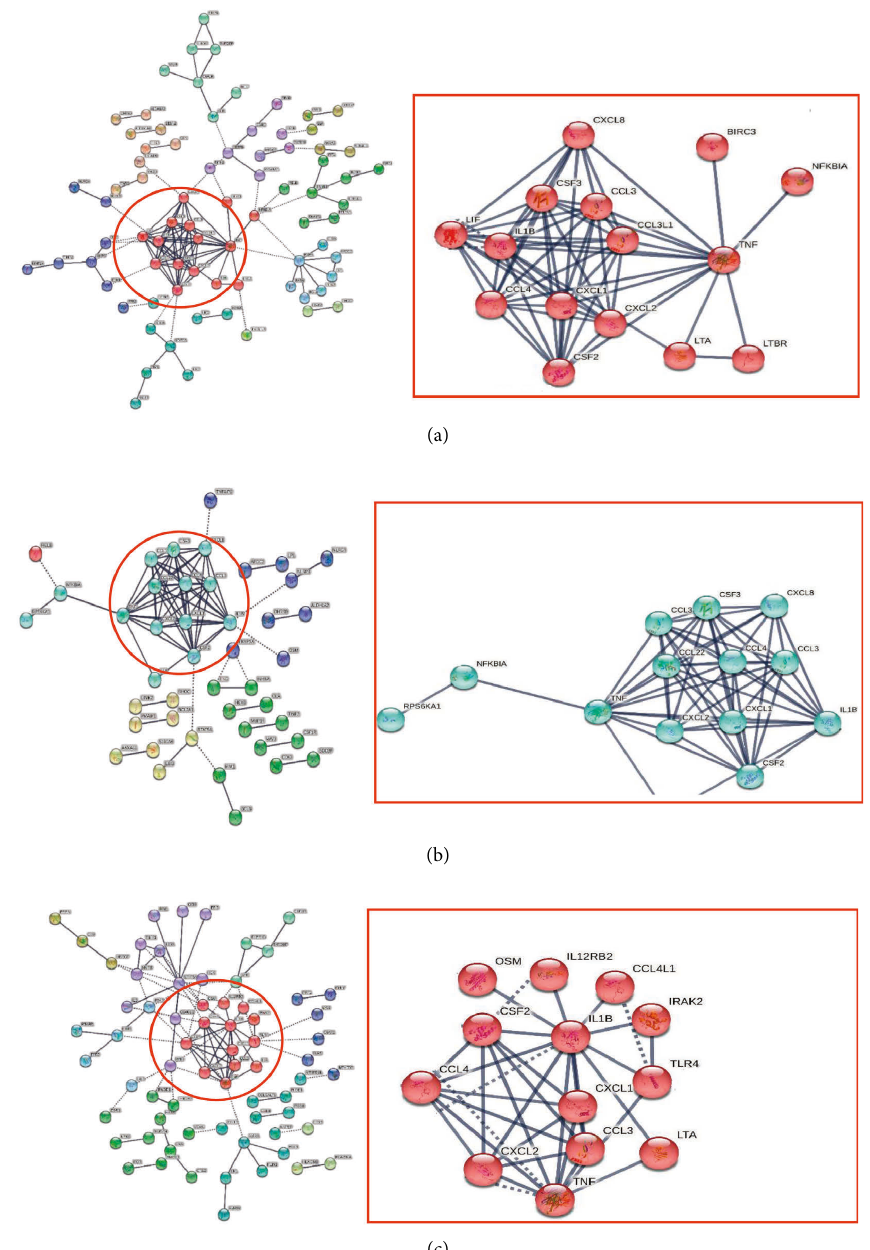
Figure 2: PPI analysis of genes expressed in severe COVID-19 to PBMC challenge with BCG or PPD. PPI of group 1 versus group 3 (a), group 1 versus group 4 (b), and group 1 versus group 5 (c). The PPI was created using the highest confidence score of 0.9. Annotation results show that different genes play a significant role in the severity of